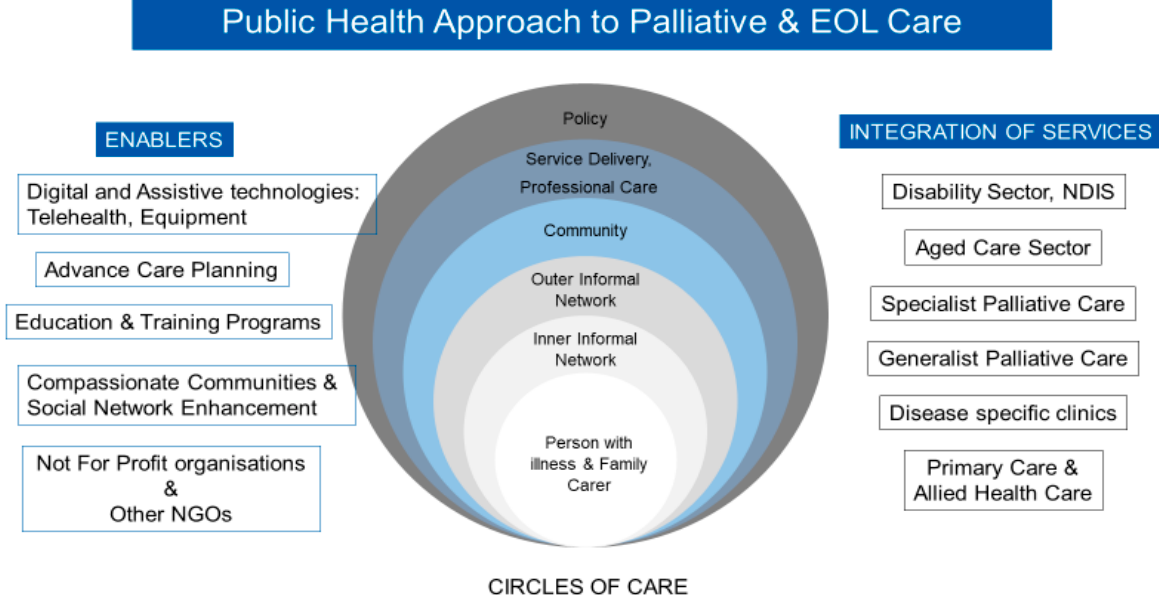
Figure 3. Public Health approach to palliative and EOL care.